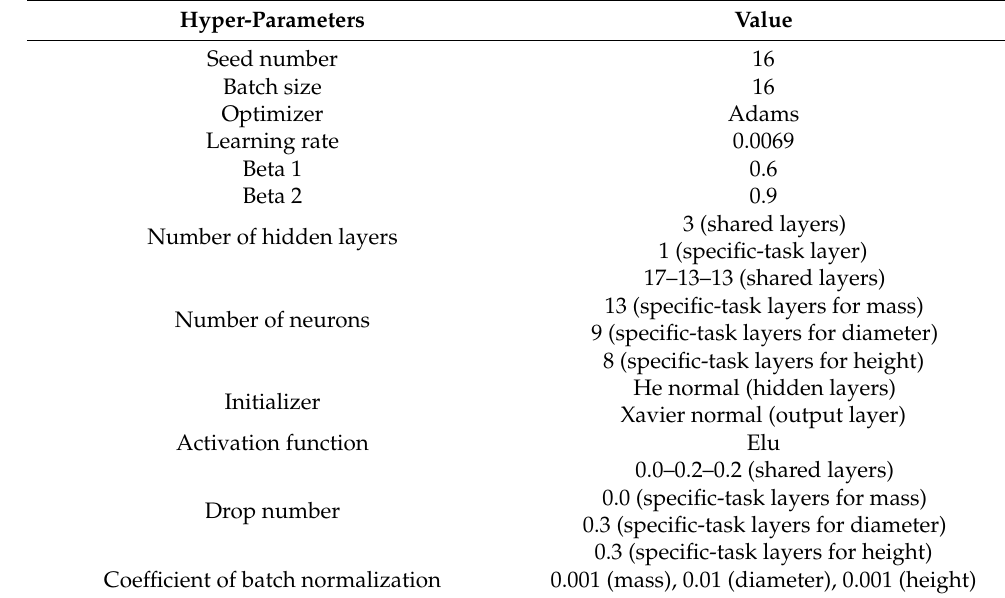
Table 8. Optimized hyper-parameters for the linear relationship group.